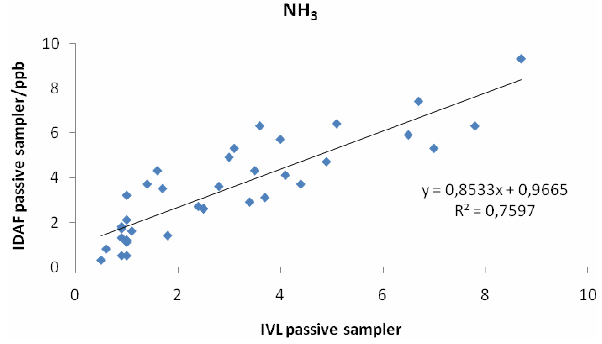
Fig. 4. Comparison of the IDAF and IVL NH3 passive samplers Figure 4 : Comparison of the IDAF and IVL NH 3 passive samplers (GURME project) (GURME project) exposed at IDAF stations from 1998 to